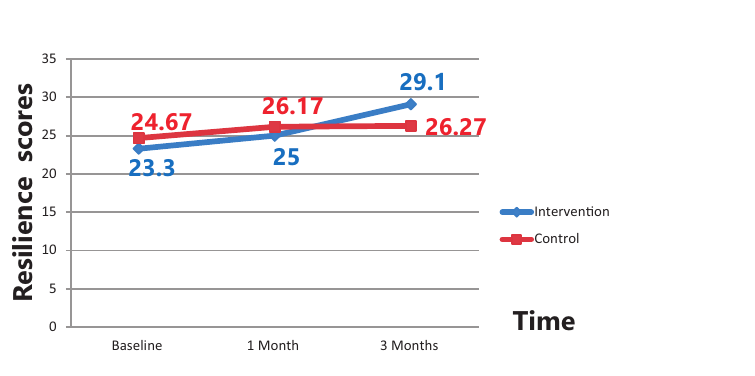
Table 3. Comparison of resilience scores (Test of within-groups)